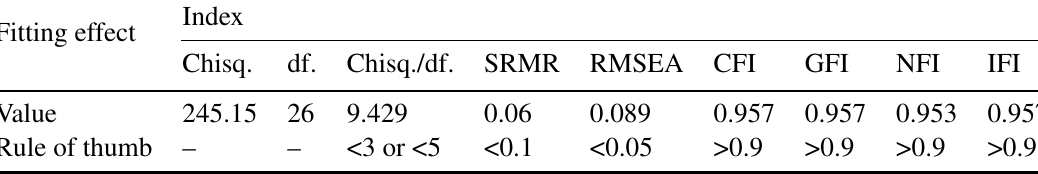
Table 6 Fitting index of structural equation